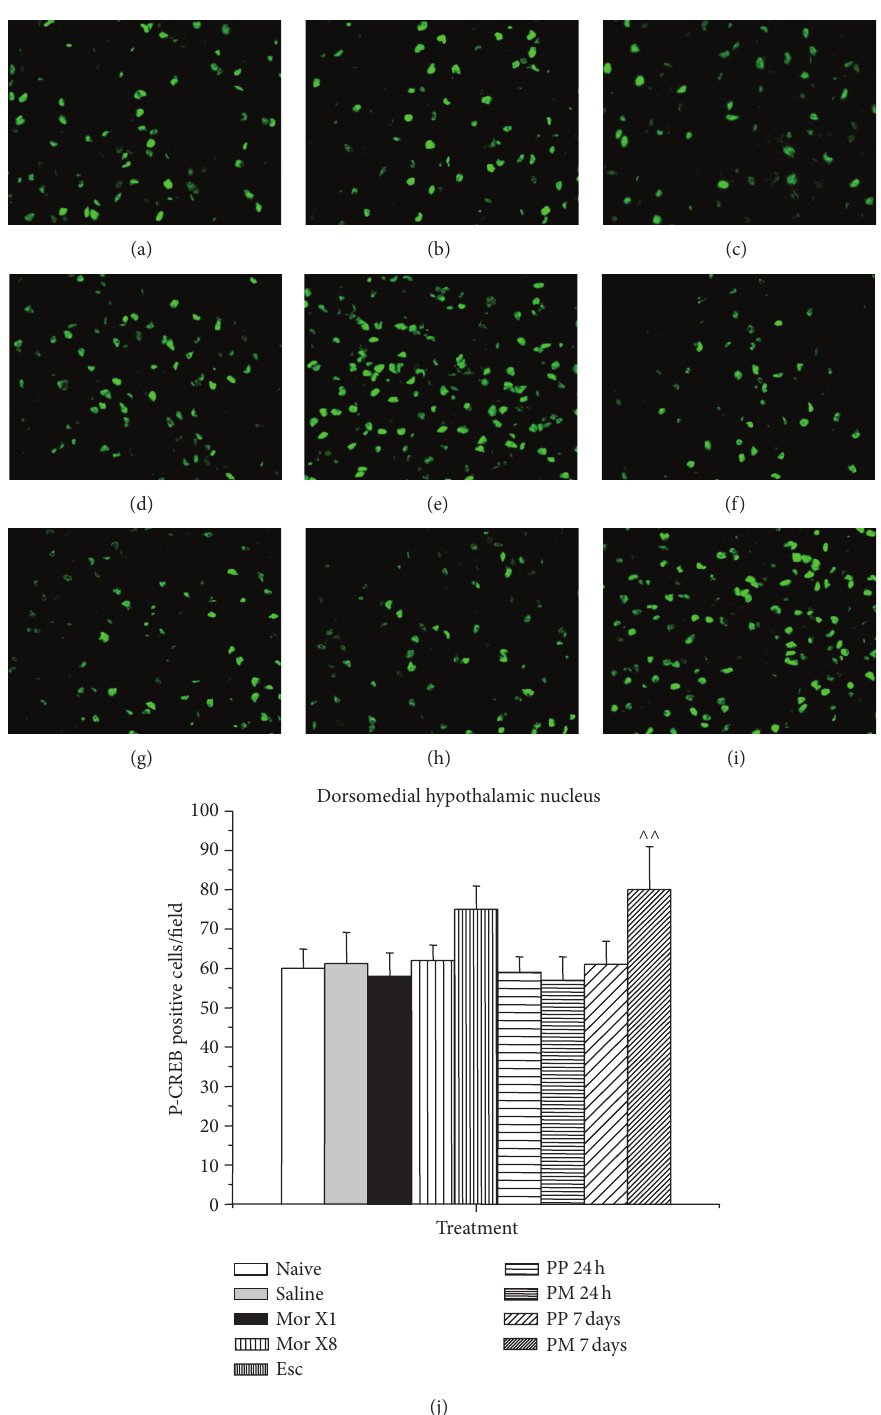
Figure 5: Changes in P-CREB staining in the DM following different morphine treatments ((a) group 1, na¨ıve; (b) group 2, saline; (c) group 3, MorX1; (d) group 5, MorX8; (e) group 6, Esc; (f) group 7, PP24h; (g) group 8, PM24h; (h) group 9, PP7d; (i) group 10 PM7d) as determined by immunofluorescence (200X). Quantification of P-CREB (j). See Table 1 for details on the morphine treatment paradigm. ∗∗ 𝑃 < 0.01 versus saline injection, ∧∧ 𝑃 < 0.01 versus saline and 7 d placebo